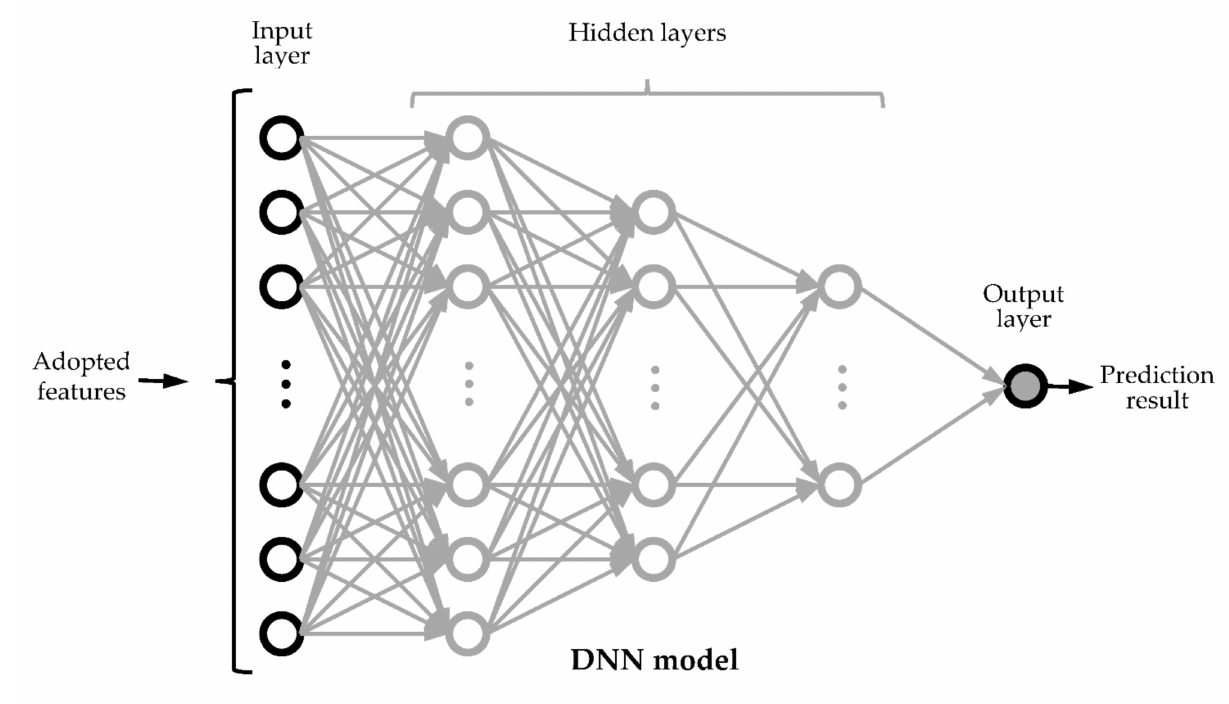
Figure 3. Structure of deep neural network